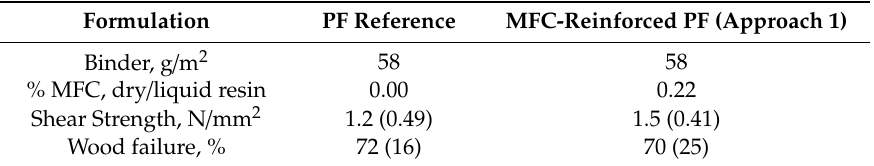
Table 11. Plywood panels analysis, MFC 2%, Approach 1.